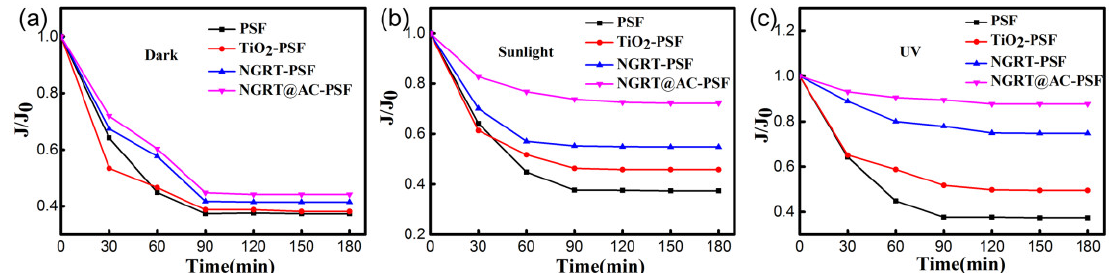
Figure 11. The flux of MO solution for all membranes under ( a ) dark, ( b ) sunlight and ( c ) UV conditions. Conditions: [MO] 0 = 30 mg/L, 150 mL, effective area 17.34 cm 2 .